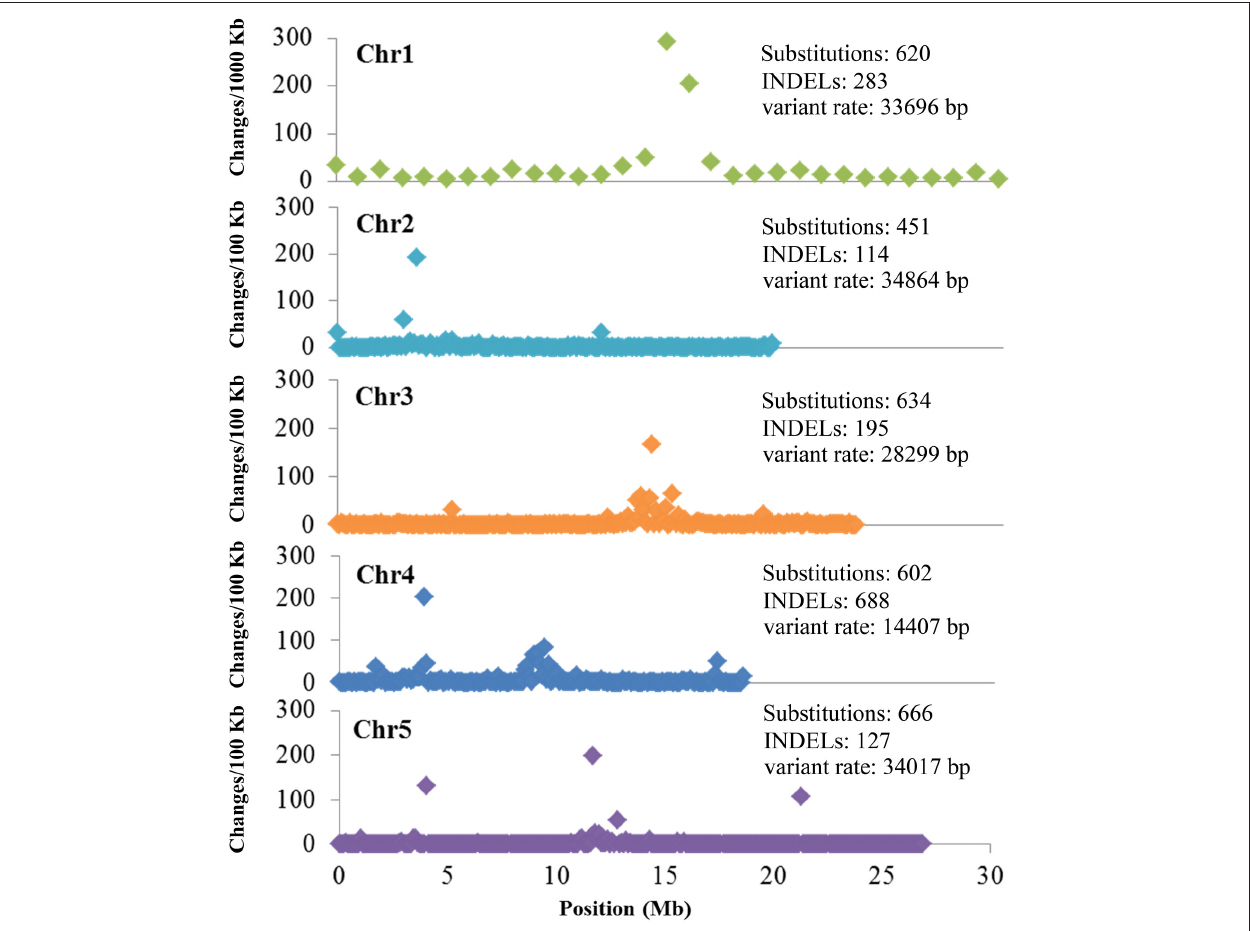
FIGURE 2 | Background mutations shared by the 12 re-sequenced Arabidopsis thaliana lines. Shown are the density and variant rate of the single base substitutions and small INDELs that were shared by 12 re-sequenced lines across each chromosome.